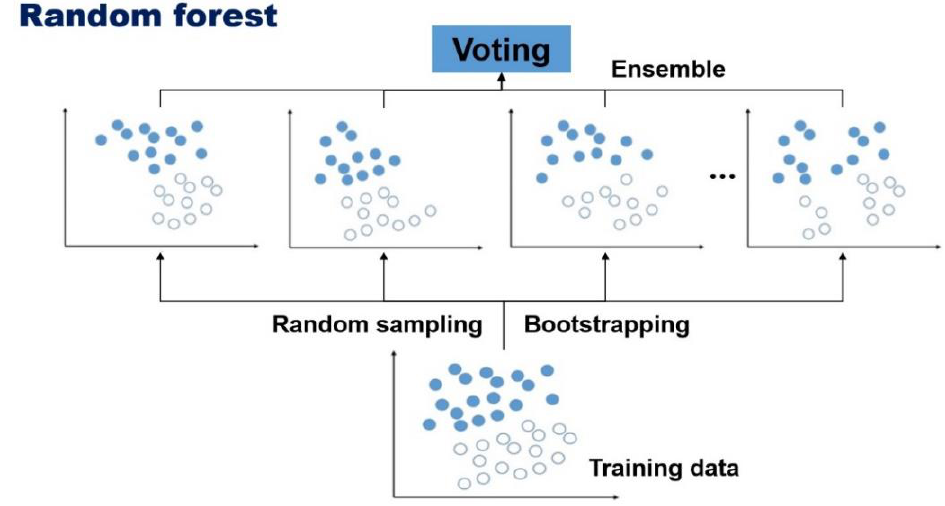
Figure 2. Modeling process of random forest algorithm.